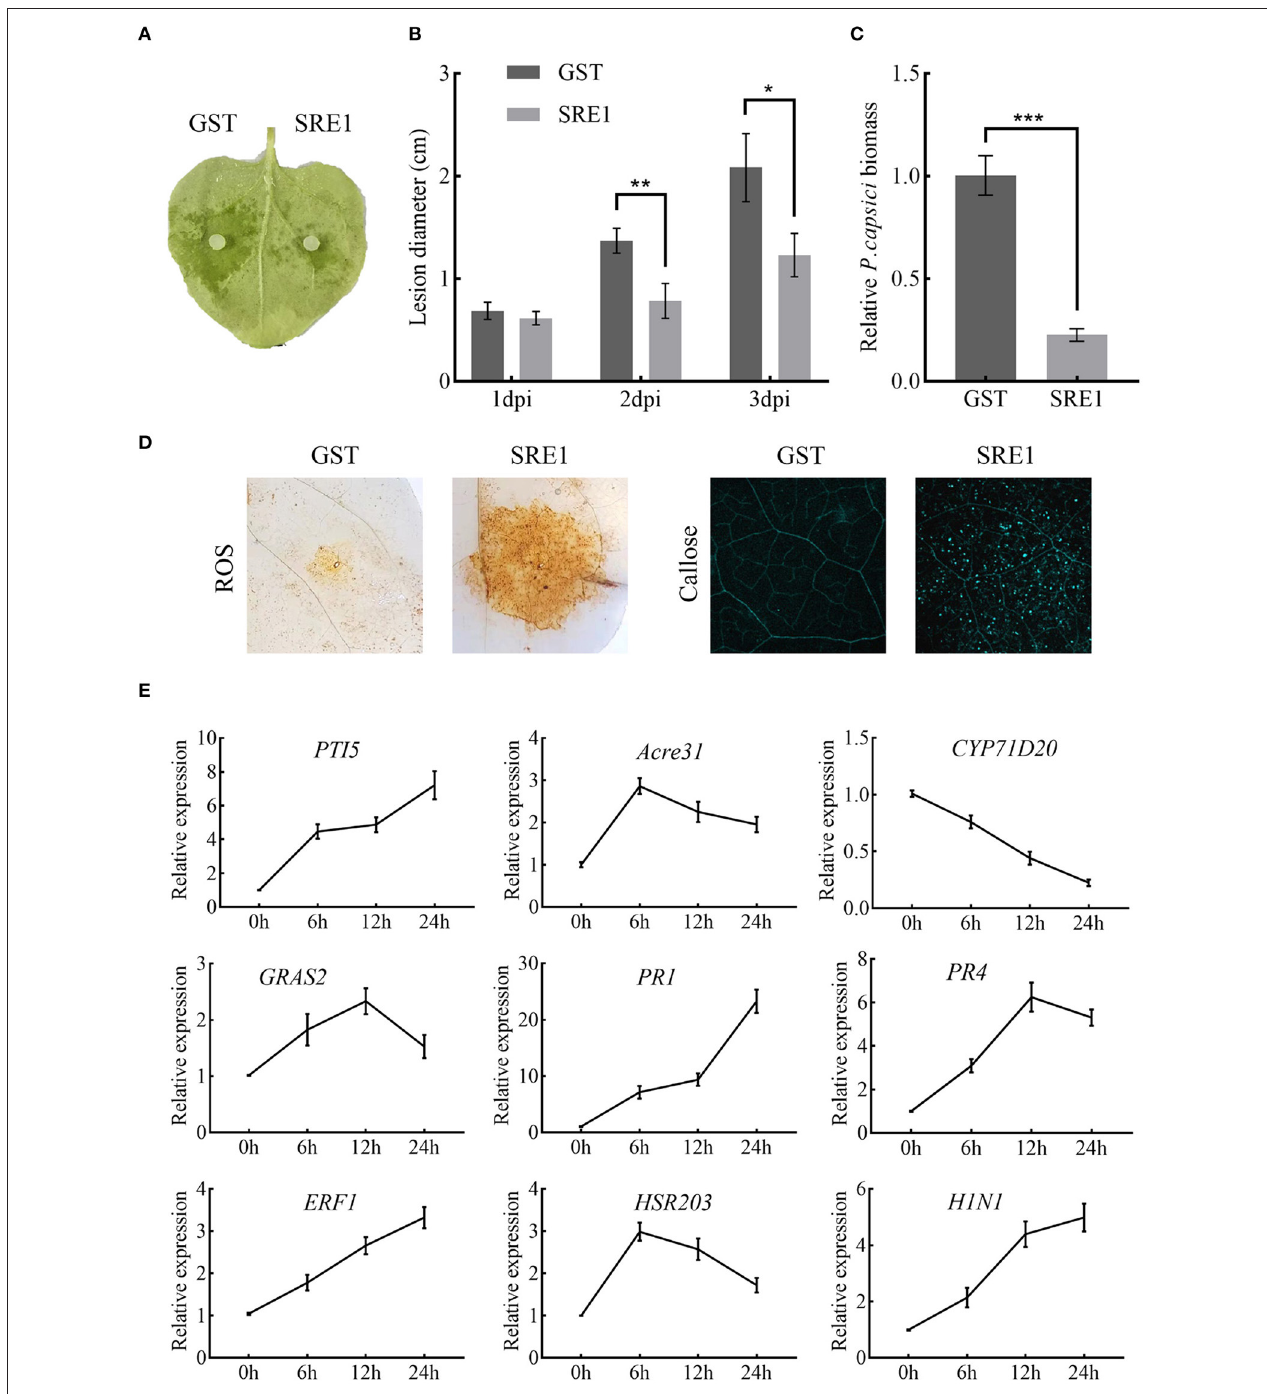
FIGURE 7 | SRE1 triggers immune responses in N. benthamiana. (A) Pretreatment with 1 µ g/mL SRE1 significantly increased resistance against the oomycetes pathogen P. capsica . The photograph was taken 2 days post-inoculation (dpi). (B) The lesion diameter was evaluated at 1, 2, and 3 dpi. The bars are the average of three independent experiments, and the error bars indicate standard deviations (* P < 0.05, ** P < 0.01, Student’s t -test). (C) Infected leaves were collected 48 h post-inoculation, and total DNA was extracted for qPCR analysis. NbEF-1 α was used as a reference gene, and the relative expression of PcActin was calculated as the relative pathogen biomass. The bars are the average of three independent experiments, and the error bars represent the standard deviations (*** P < 0.001, Student’s t -test). (D) ROS and callose production in N. benthamiana leaves treated with 1 µ g/ml SRE1. (E) Relative expression of the PTI-associated marker genes ( PTI5 , Acre31 , CYP71D20, and GRAS2 ), pathogenesis-related genes ( PR1 , PR4, and ERF1 ), and HR genes ( HSR203 and H1N1 ). Relative expression was quantified by qRT-PCR using NbEF-1 α as a reference gene. Bars indicate mean fold changes ( ± SD ).